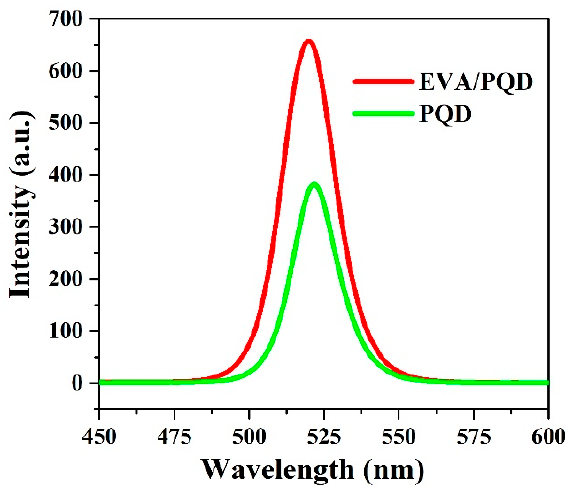
Figure 3. PL spectra of the EVA-TPR/ PQD surface and the pure PQD thin films. The excitation wavelength was 355 nm.